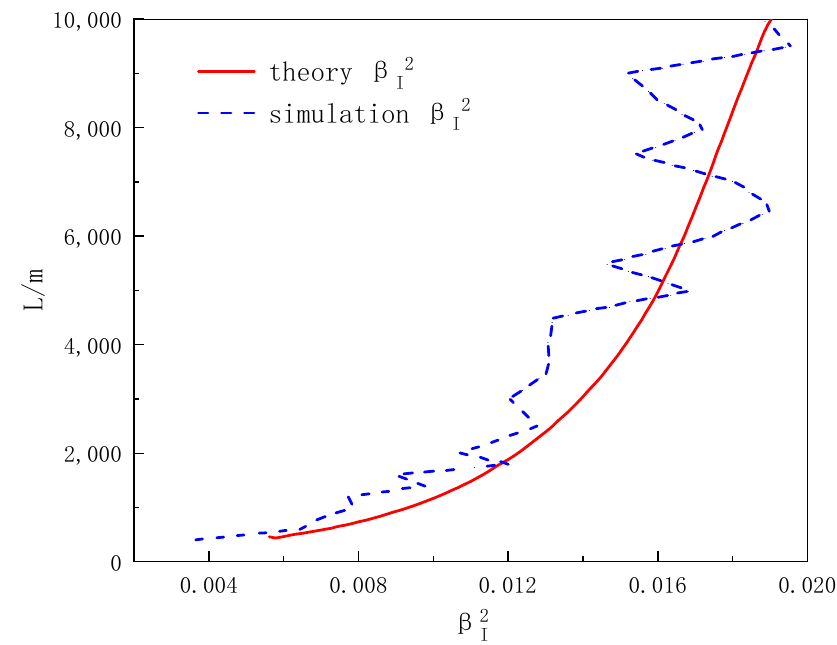
Figure 12. Distribution of scintillation index with transmission distance.